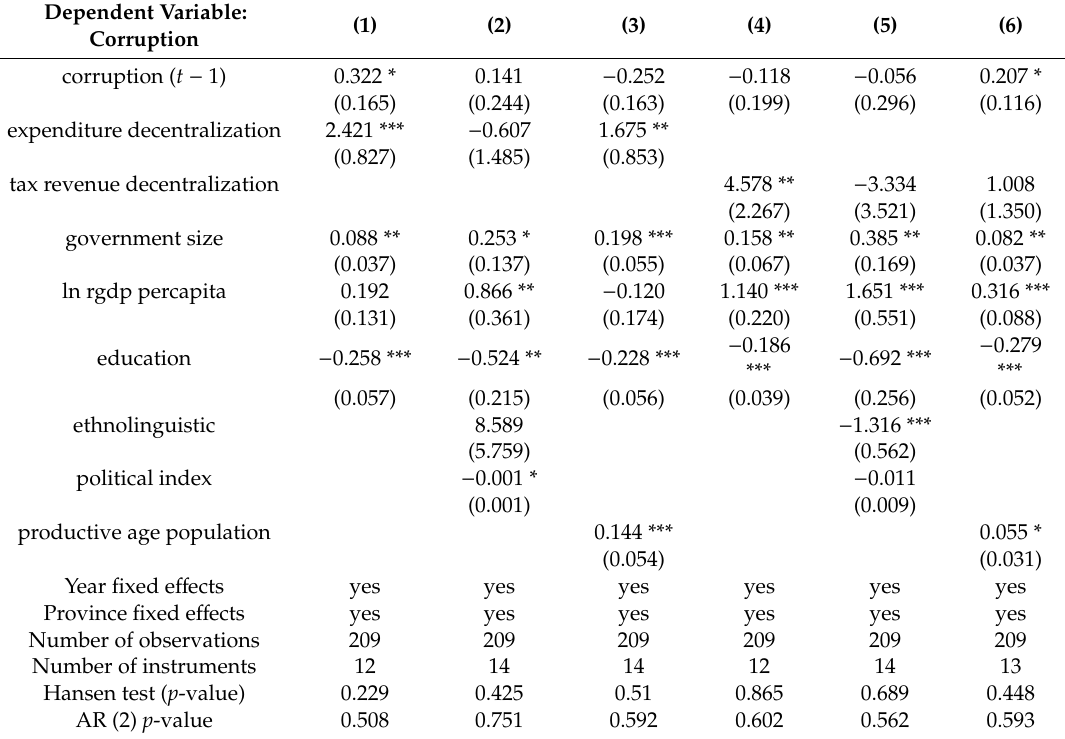
Table 4. System Generalized Method of Moments (GMM)